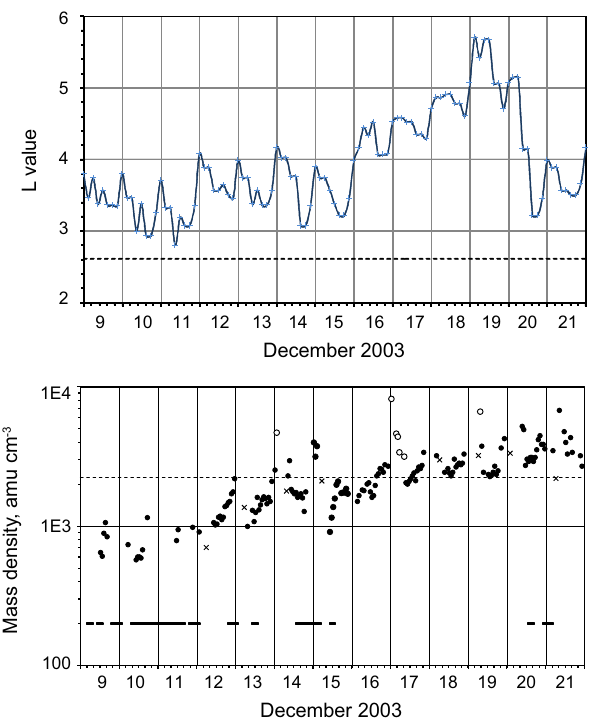
Fig. 2. (a) Plasmapause location given by Moldwin et al. (2002) model for 9–21 December 2003. Horizontal dashed line at L = 2.61 shows location of magnetometer pair midpoint. (b) Mass density at L = 2.61 over 9–21 December 2003. Solid horizontal lines indicate intervals where Kp (cid:6) 4 + ; dashed horizontal line represents average mass density from the Berube et al. (2005) model. Open circles identify likely quarter mode oscillations and crosses denote VLF- derived electron